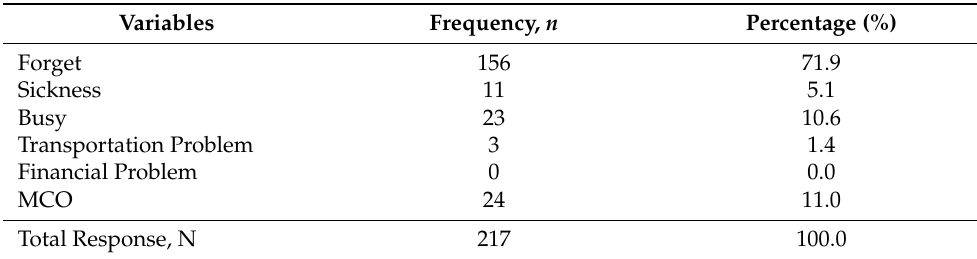
Table 1. Causes of missed appointment as mentioned by the